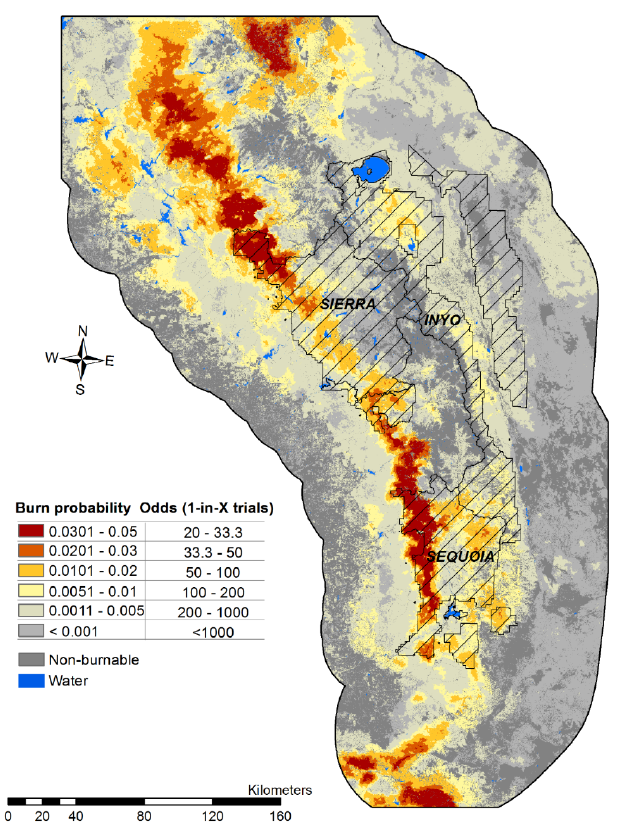
Figure 6. Burn probability results for the Southern Sierra Risk Assessment landscape.